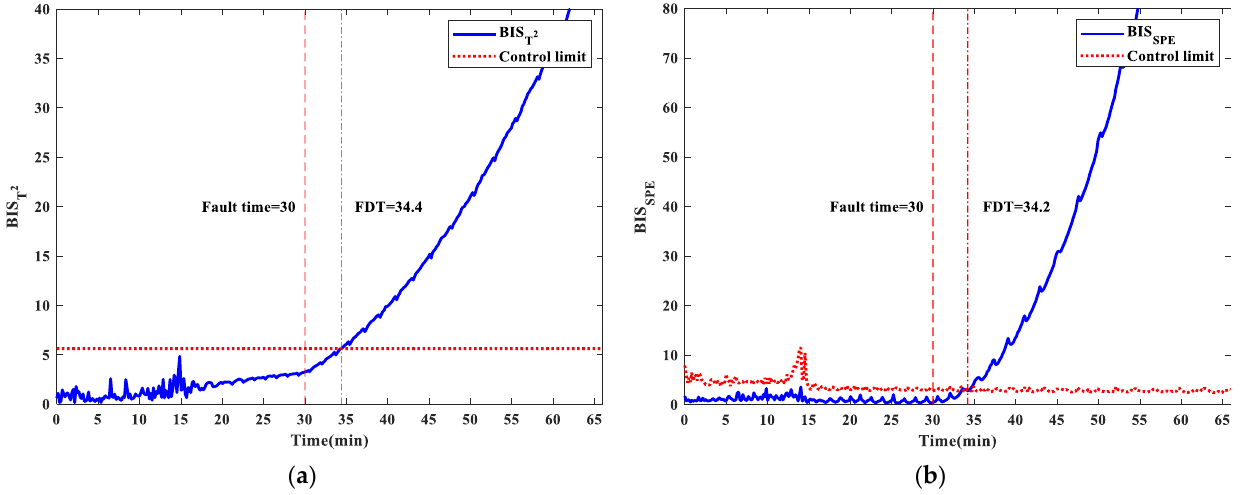
Figure 6. Fault monitoring charts of F2 based on NMI-WMPCA: ( a ) 𝑇 2 monitoring chart; ( b ) SPE monitoring chart.